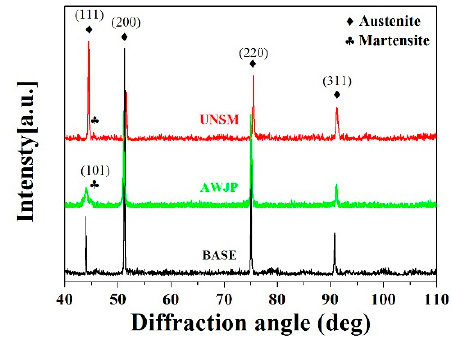
Figure 6. The X-ray diffraction pattern of BASE, AWJP and UNSM specimens.